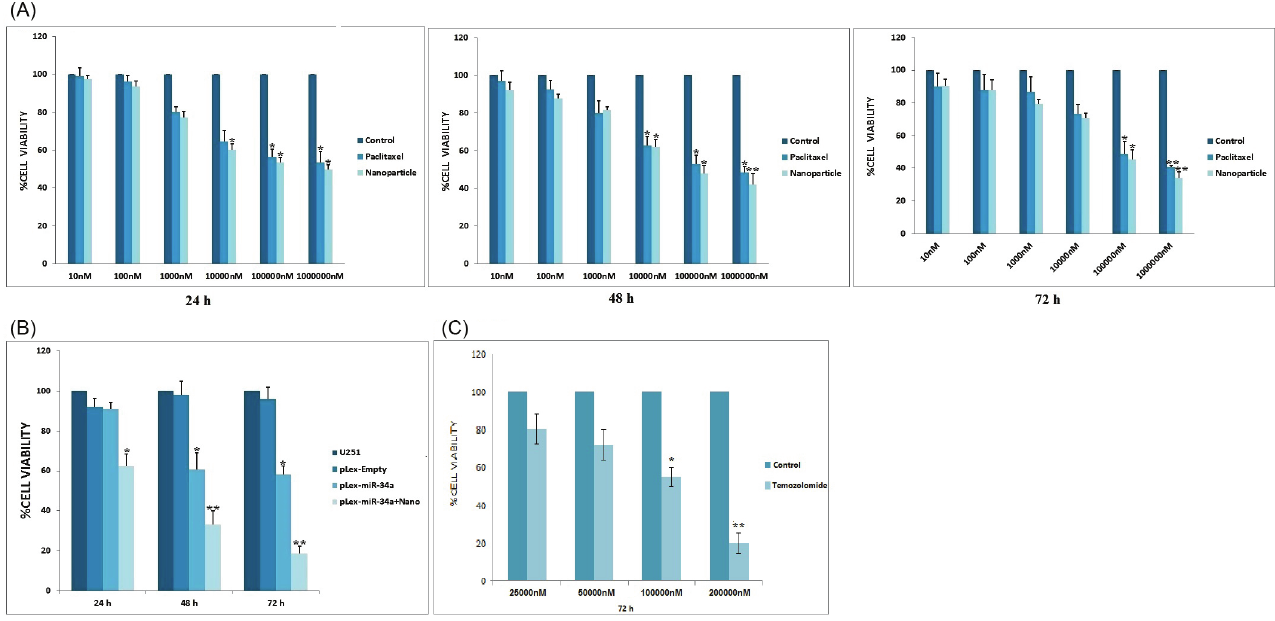
FIGURE 2 - The effect of paclitaxel and albumin-bound paclitaxel nanoparticles on cell viability of U251 cells after (A) 24 h, (B) 48 h and (C) 72 h treatment. Data were the averages of at least three independent runs; bars, SD. [*] P<0.05 [**]